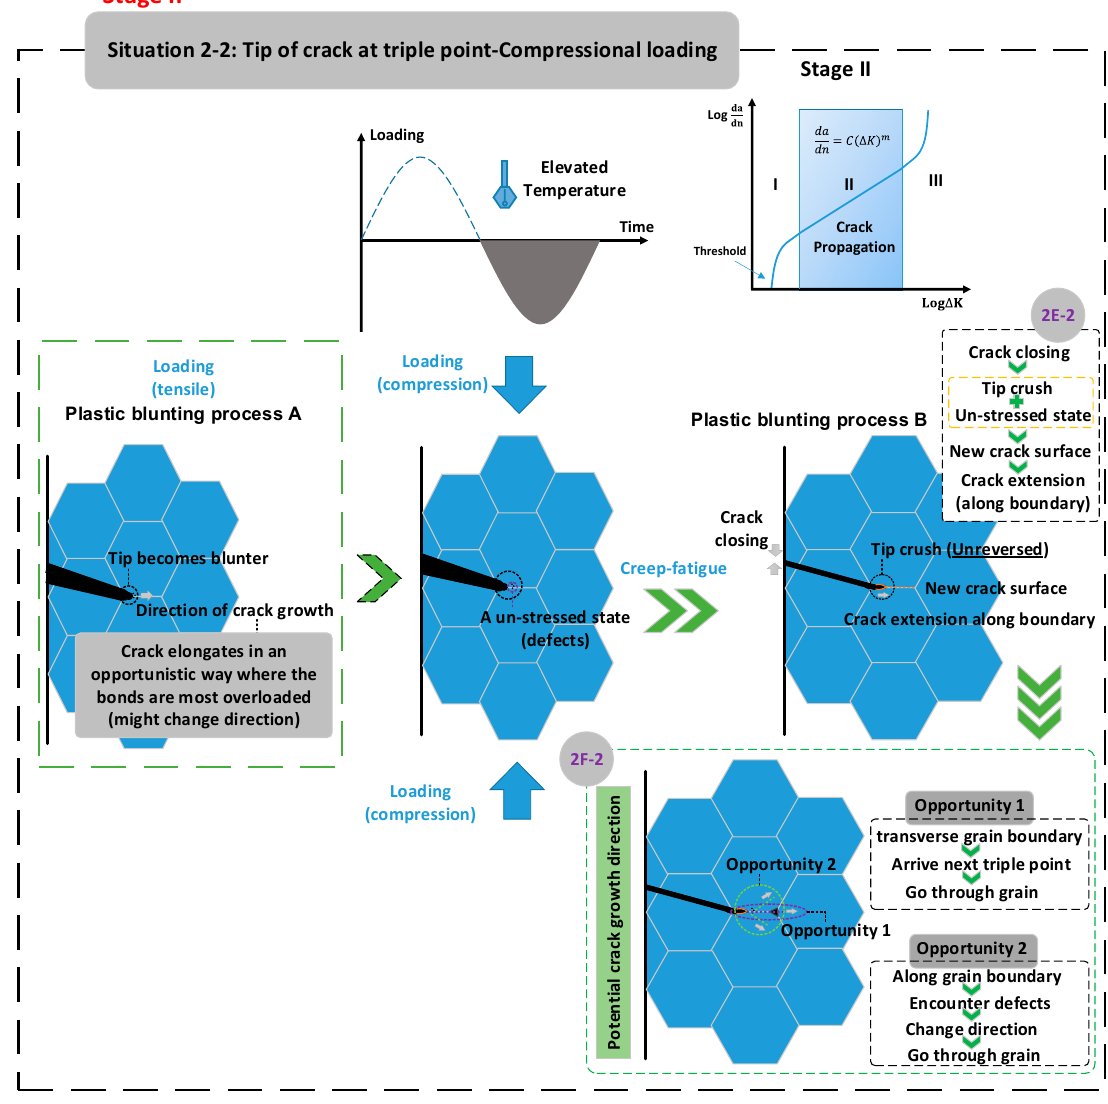
Figure 15. Crack tip at triple point—Compressional loading. Metals 2018 , 8 , x FOR PEER REVIEW 16 of 34